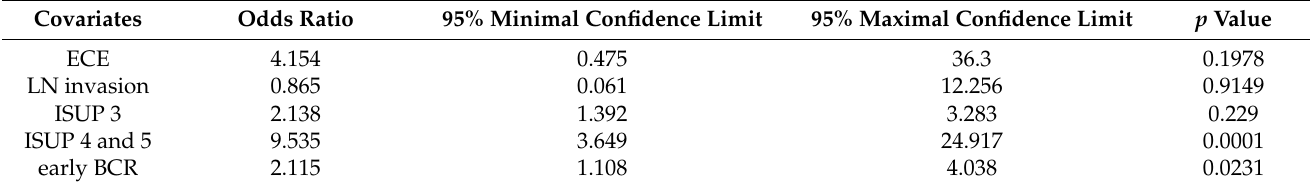
Table 1. Binary logistic regression predicting Intermediate/High Decipher risk category.